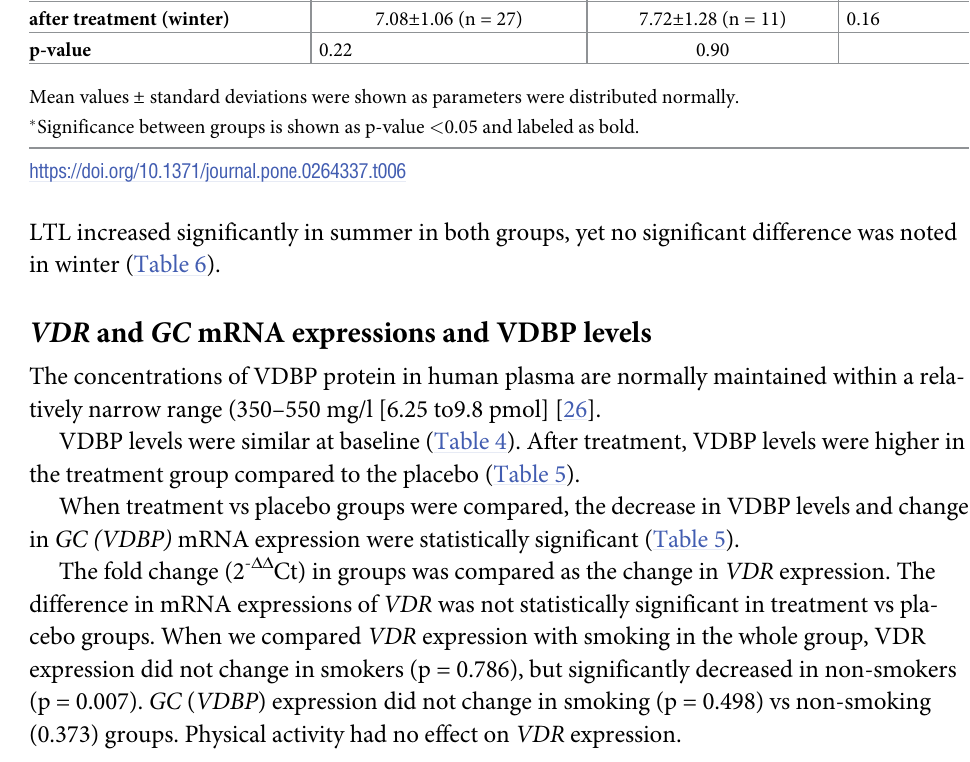
Mean values ± standard deviations were shown as parameters were distributed normally. � Significance between groups is shown as p-value < 0.05 and labeled as